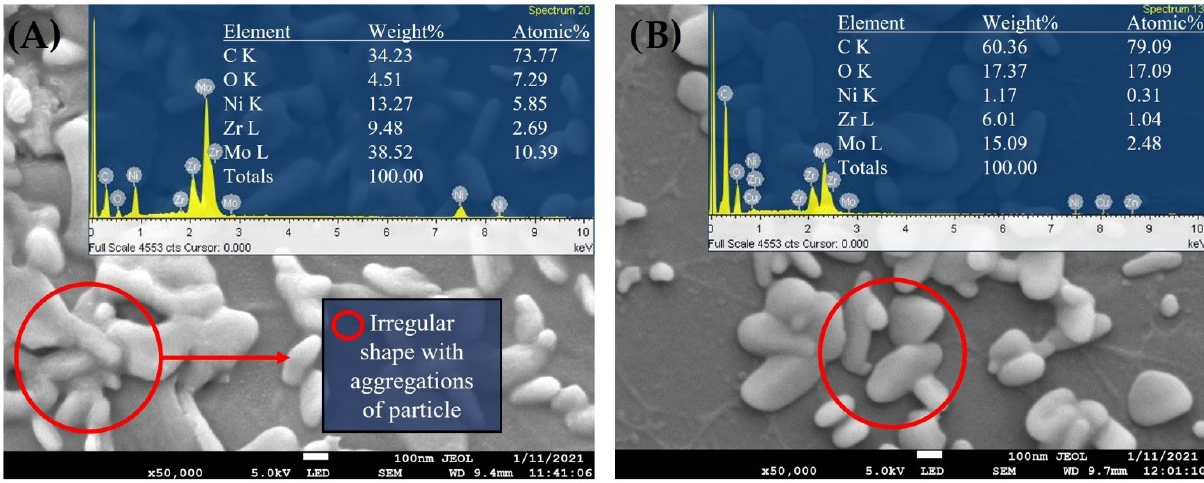
Figure 6. FESEM images of impregnated Biochar AC with metal oxide at ( A ) 400 °C and ( B ) 800 °C.